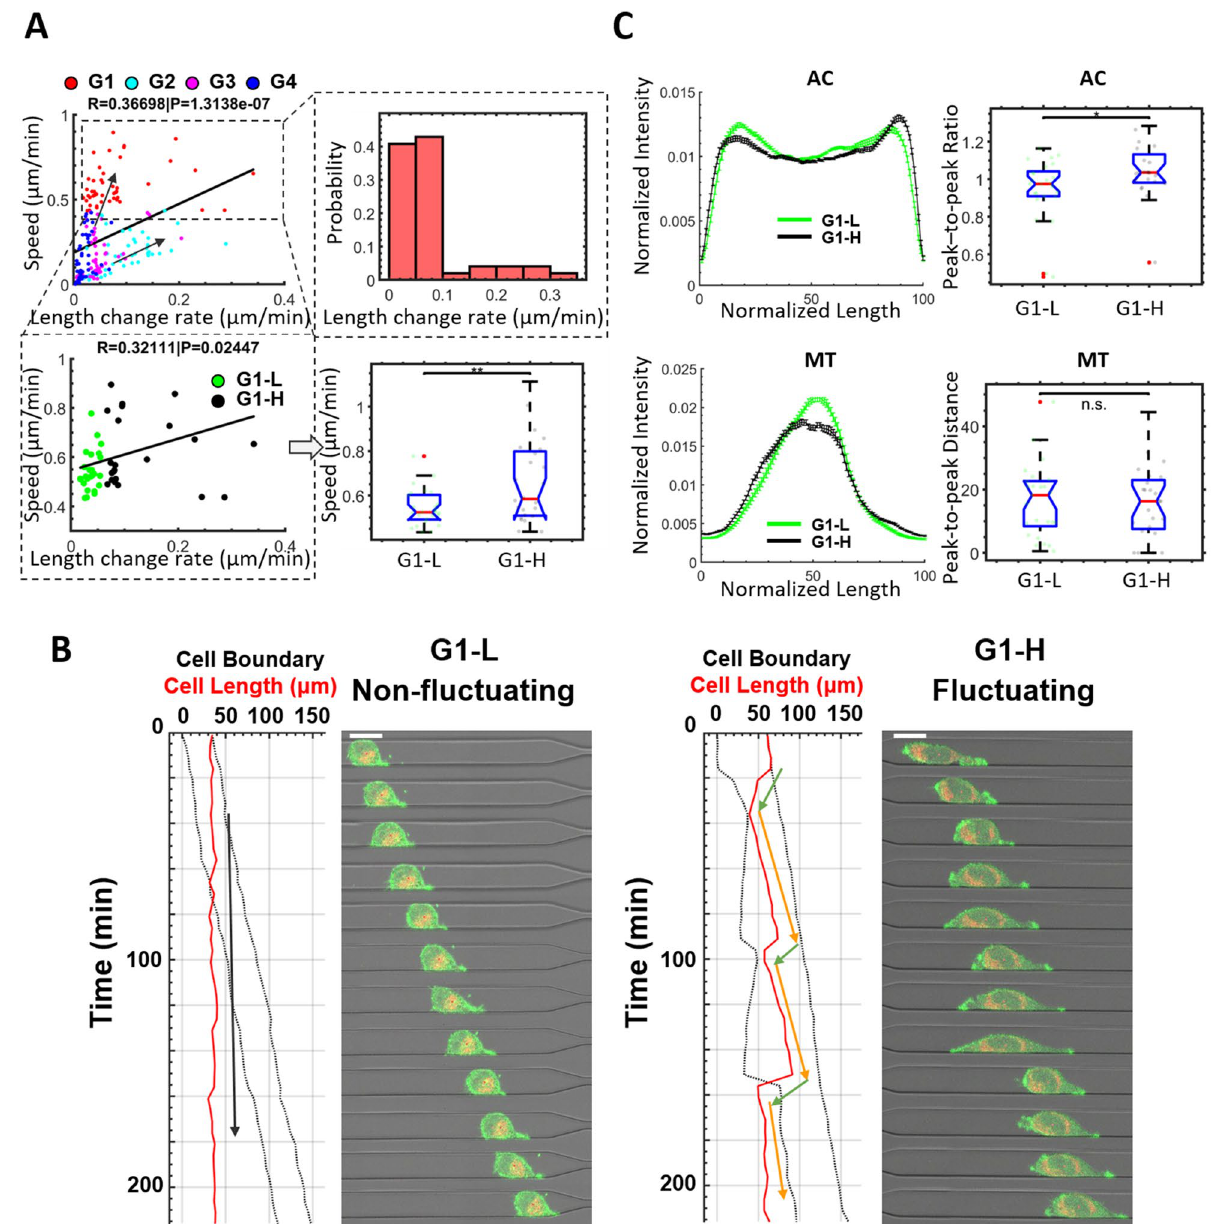
Figure 2. Two distinct migratory phenotypes in the fastest group G1. ( A ) Upper left: The speed vs. length change rate relationship (absolute value of the rate of cell length change) for all cells in the wide channel is shown in the scatter plot. The solid black line is the linear fit of the scatter plot. R and P values are shown on the title. R is Pearson’s correlation coefficient. The cells are color-coded based on the group. The black arrows point along with the two phenotypes, fluctuating (high speed, high length change rate) and non-fluctuating (high speed, low length change rate). Upper right: The probability plot shows the distribution of cell length change rate in the fastest group G1. Lower left: The speed vs. length change rate of the cells in G1. The cells in G1 are separated into two equal-sized subgroups, G1-L (Low length speed, N = 25) and G1-H (High length speed, N = 24). Lower right: The speed of the cells is shown to compare the two subgroups. ( B ) The time-lapse images of representative cells from each subgroup (Left: non-fluctuating; Right: fluctuating) show the dynamics of cell morphology during migration, with the corresponding quantification of cell boundary and cell length displayed on the left. The dotted curves indicate the leading and trailing edge of the cell over time. The red curves indicate cell length dynamics. The arrows guide visualization of the elongation-contraction cycles. Green arrows indicate cell contraction and orange arrows indicate cell elongation. Frame interval is 20 min, scale bar = 20 μm. ( C ) The average actin (upper-left) and mitochondria (lower left) profiles are used to compare between G1-L and G1-H. The standard error of the mean is used as the error bars in the profile plots. The box plots on the right side are statistical comparisons of selected variables used to extract differences between compared